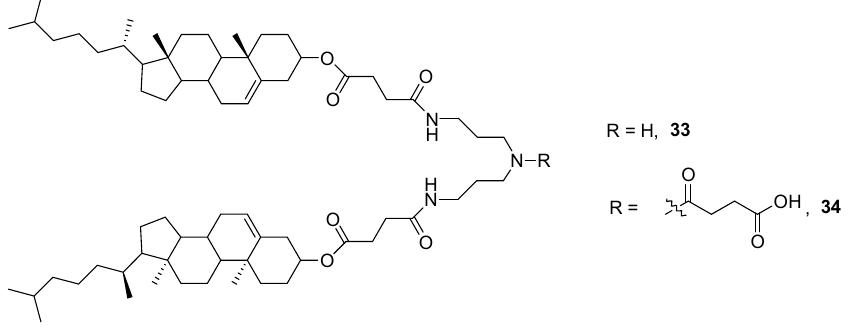
Figure 23. Examples of cholesterol derivatives examined as potential gelators.